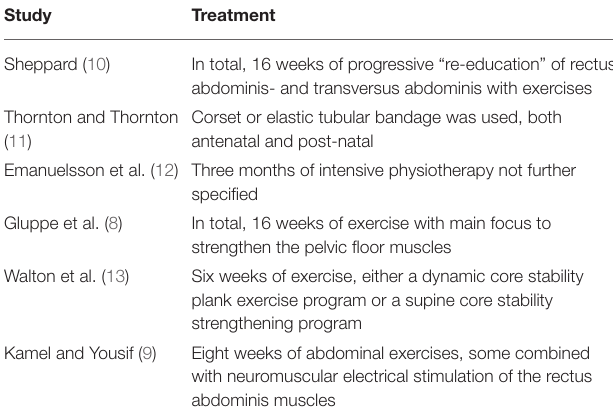
TABLE 1 | Overview of published non-surgical